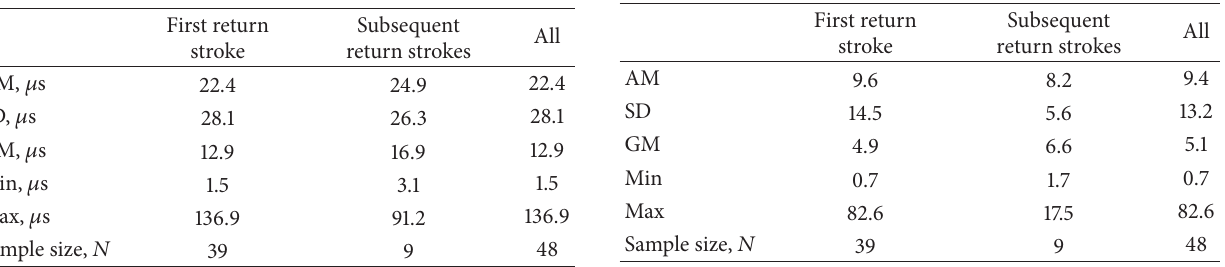
Table 2: Statistical summary of zero-to-peak rise time for 48 positive return strokes.